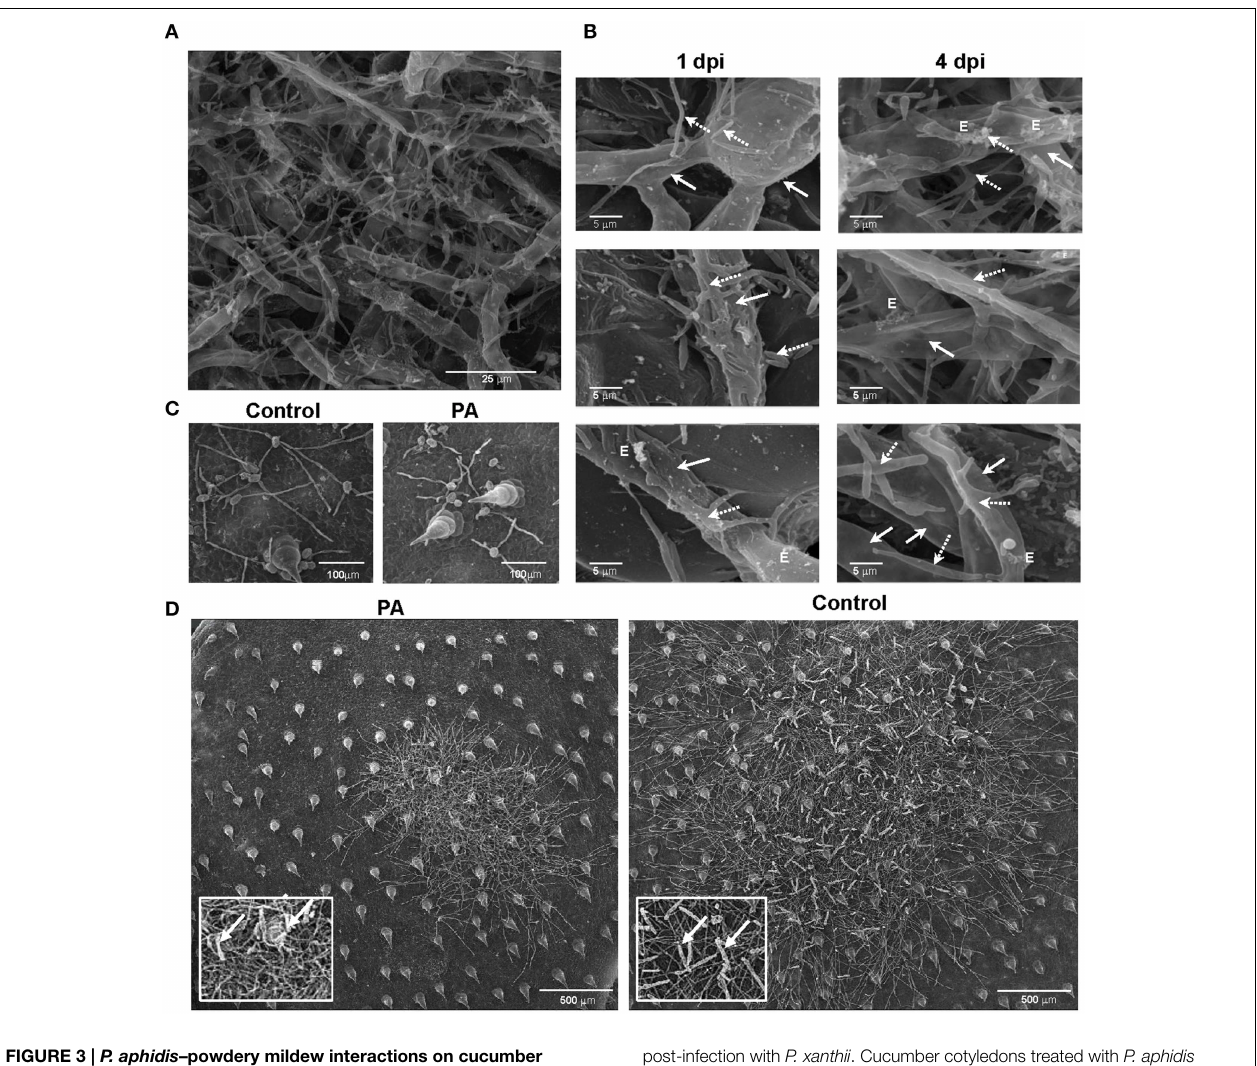
FIGURE 3 | P. aphidis –powdery mildew interactions on cucumber cotyledons. SEM microscopy of cucumber cotyledons treated with P. aphidis and infected with Podosphaera xanthii . (A) Cucumber cotyledons treated with P. aphidis 4 days post-infection with P. xanthii . (B) Closer look at the interaction of P. aphidis and P. xanthii mycelium and spores 1 and 4 days